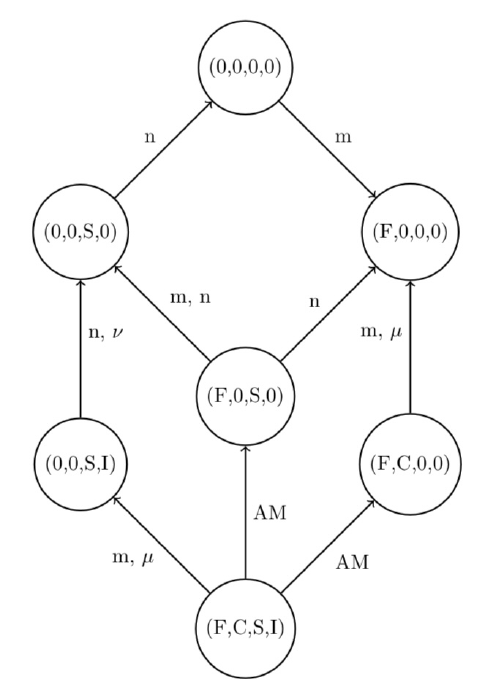
Figure 1. The graph of the equilibria for system (1) and the transcritical bifurcations relating